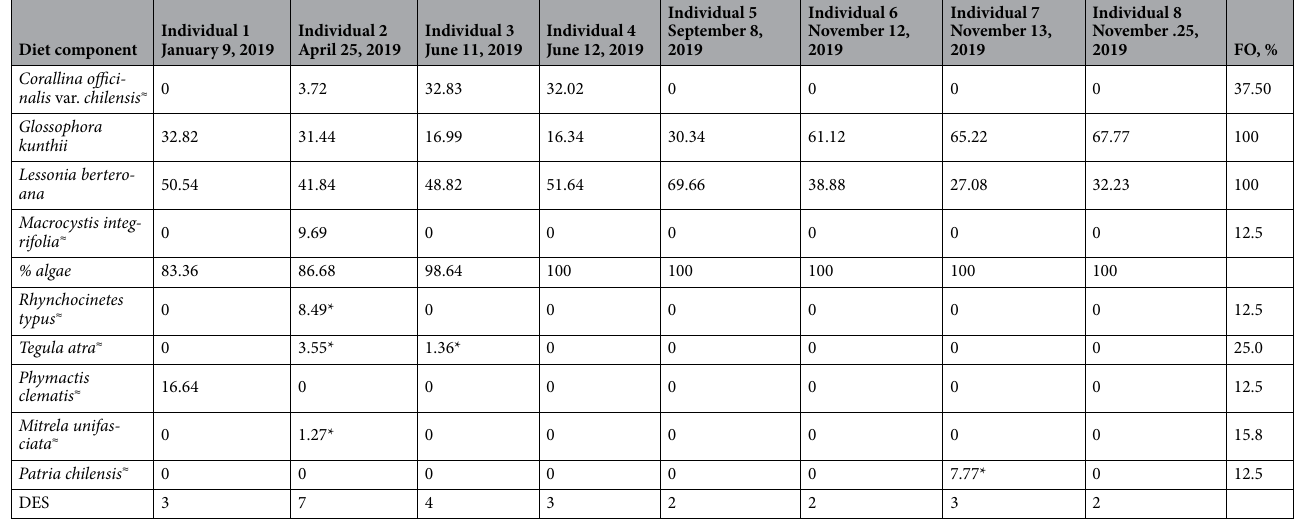
Table 2. Incidence of the components (wet weight, %), frequency of occurrence (FO, %) and diversity of elements per sample (DES) of the diet in the samples of stomach content of adult individuals of Medialuna ancietae fish collected during the year 2019 in Pisagua, North of Chile (19°36’S; 70°12’W). *Incidental component associated with macroalga. ≈ Dietary component with significant difference between individuals. P <